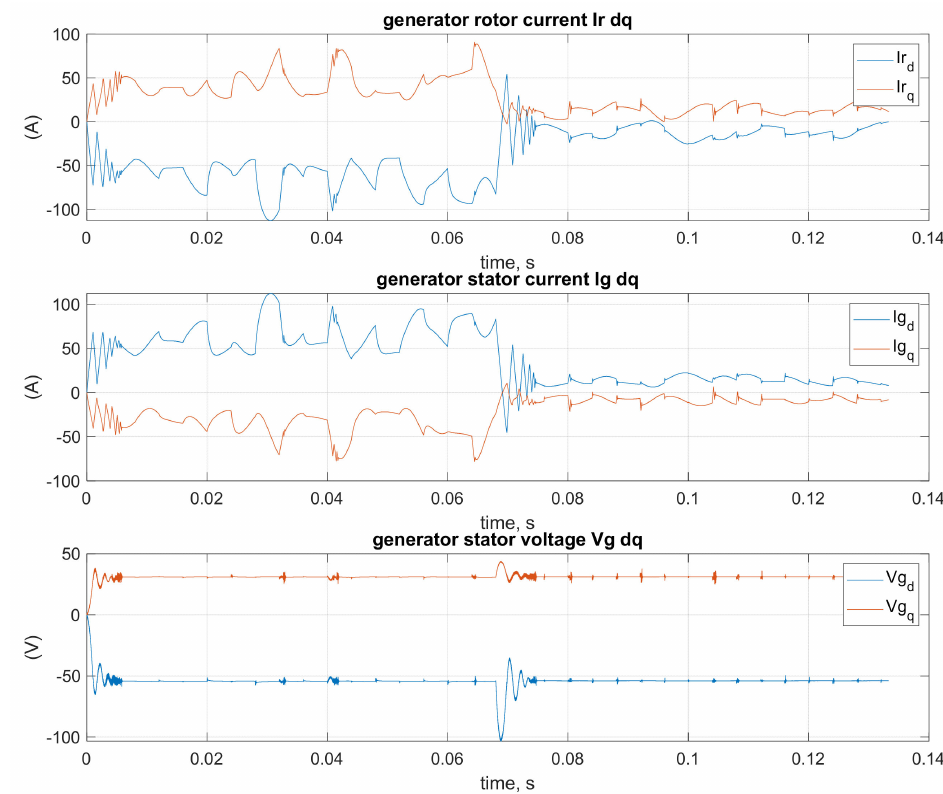
Figure 10. Stator voltage V g , stator current I g and rotor current I r with the load from Figure 9.